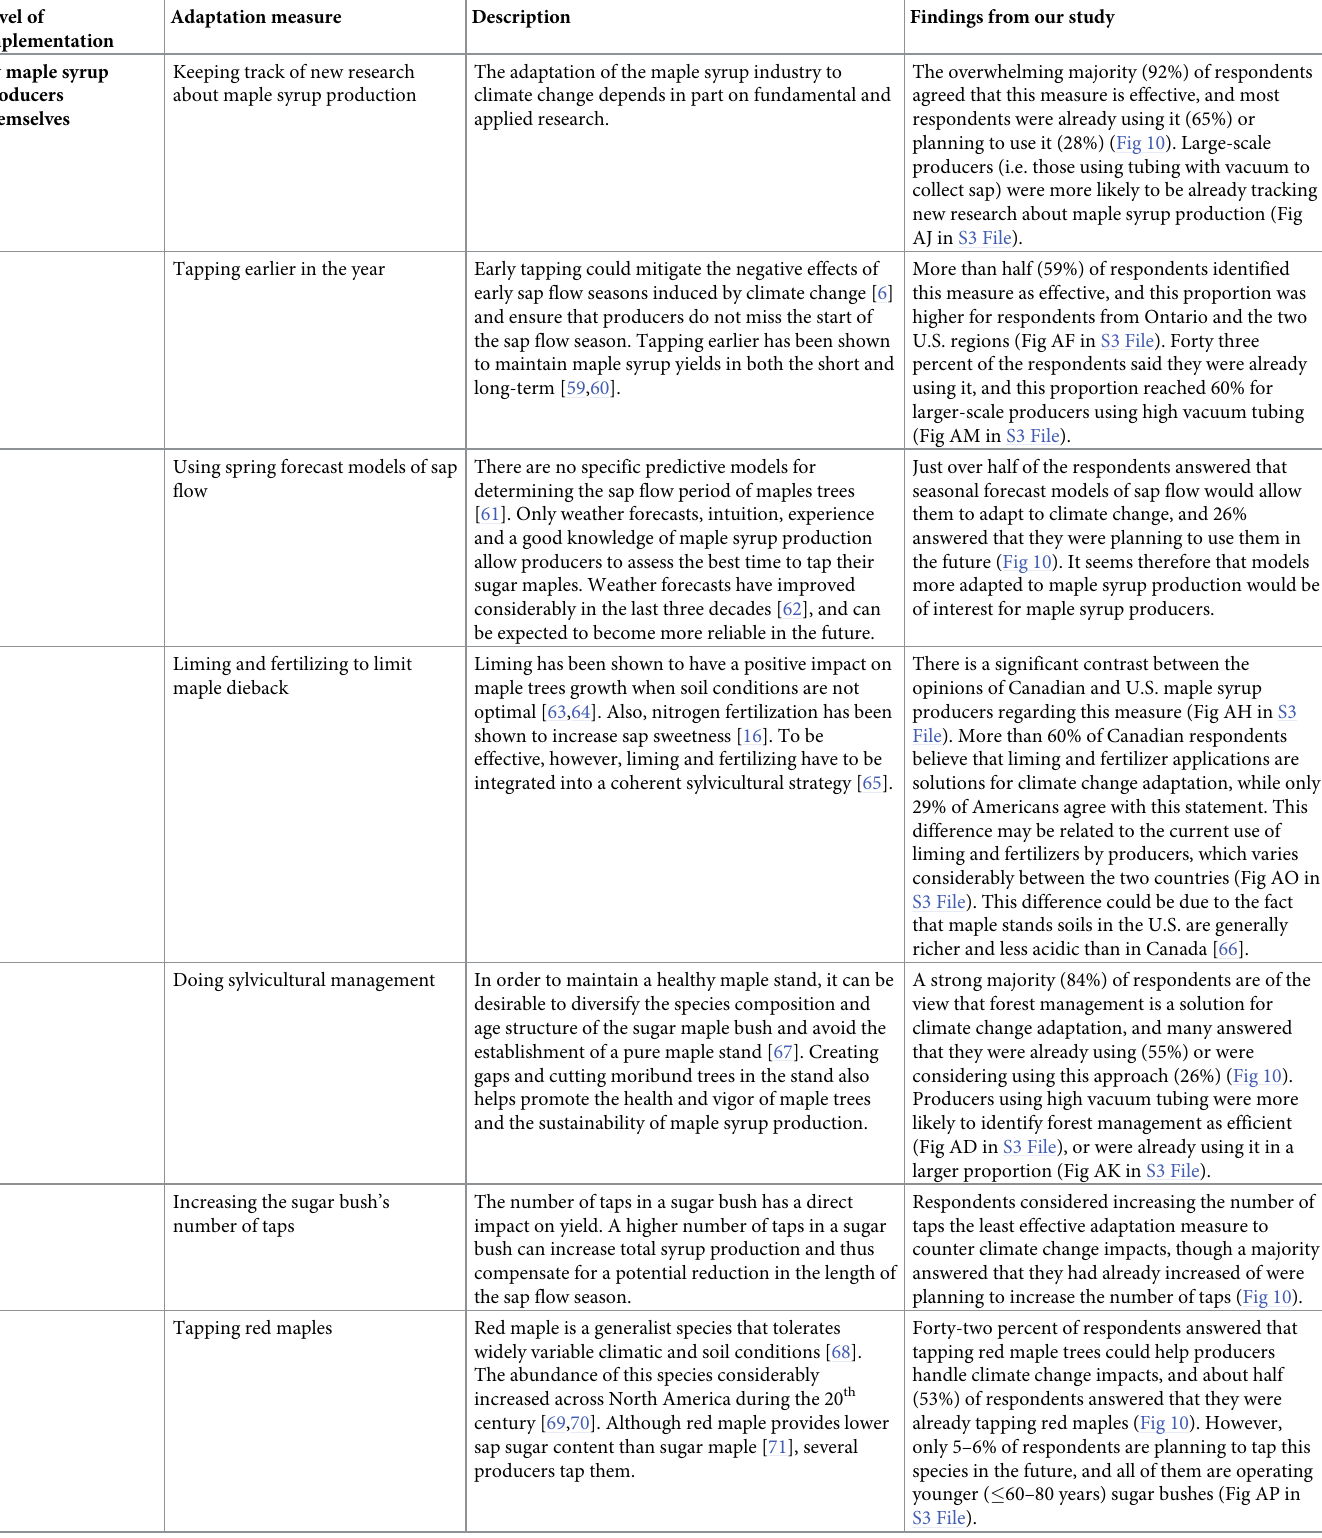
Table 4. Description of the potential adaptation measures included in the survey, with corresponding findings from our survey